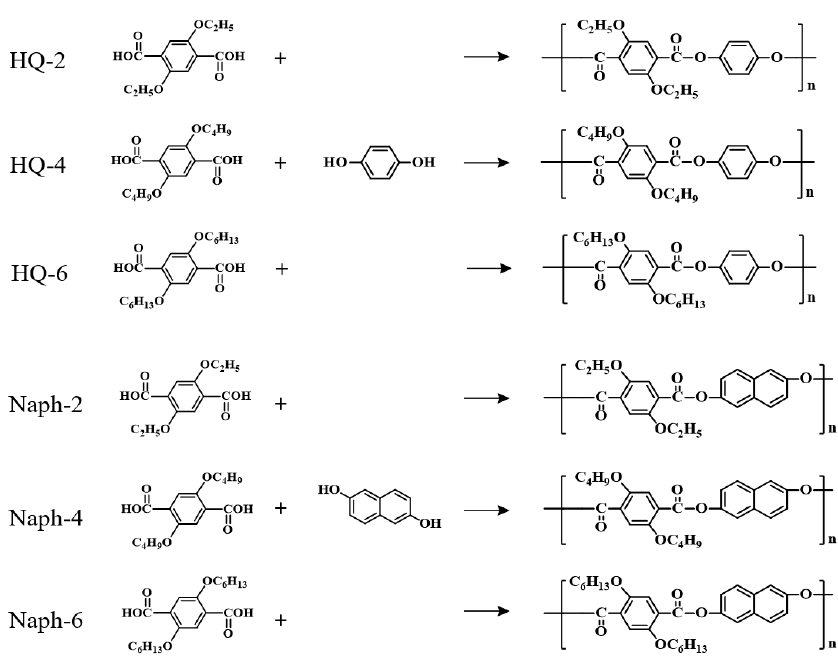
Figure 2. Chemical structures of hydroquinone (HQ)‐ and Naph‐TLCPs.